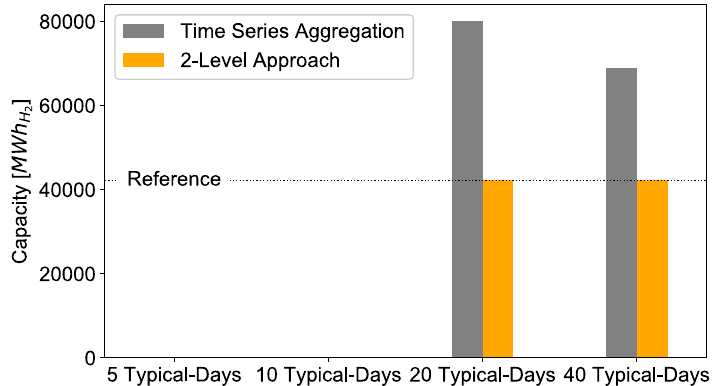
Figure 19. Deviation of installed hydrogen storage capacities with the 2-Level Approach and time series aggregation compared to full time series.